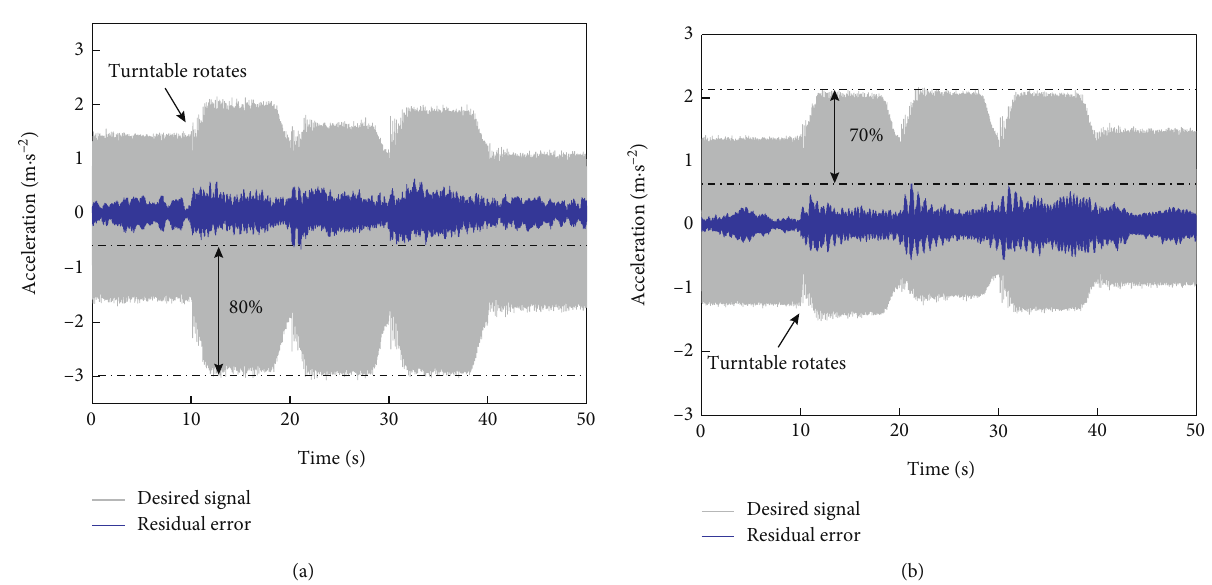
Figure 21: Acceleration response with LMS-IOBR. (a) 1# point. (b) 2#